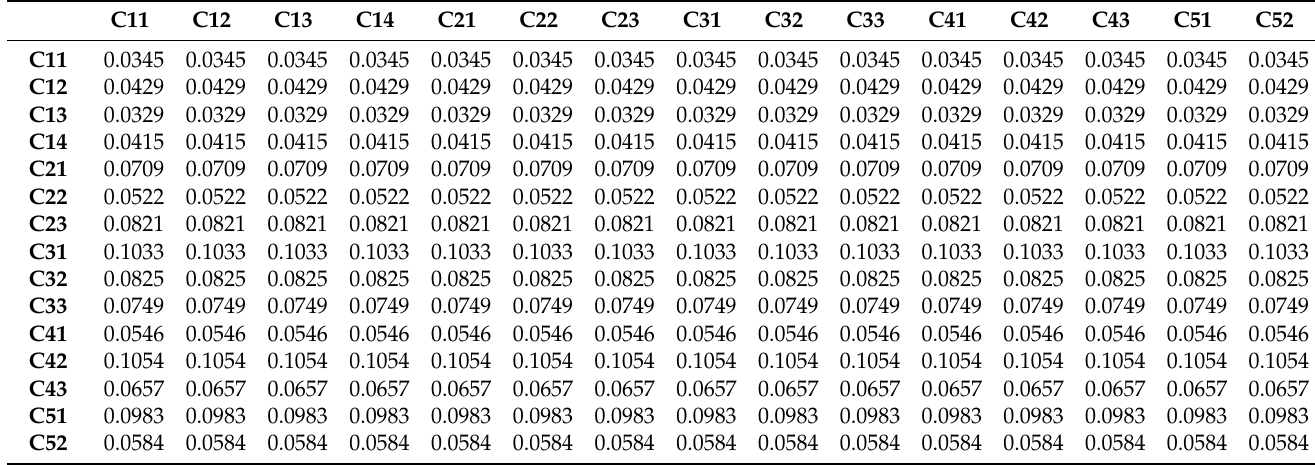
Table A12. Limited matrix during the computations of the present